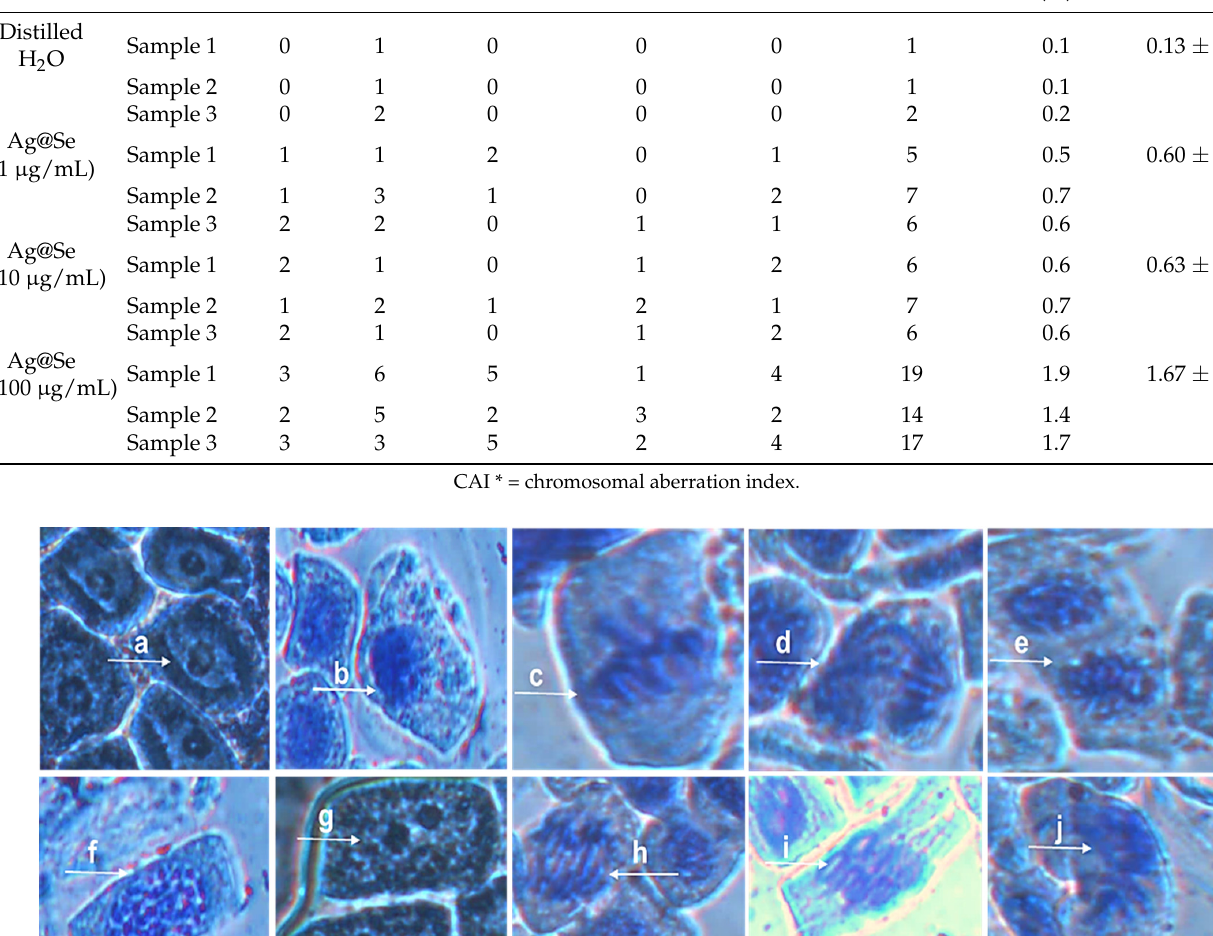
Table 6. Cytological effects per 1000 cells scored in the control and Ag@Se NP treated Allium cepa root cells. Treatment